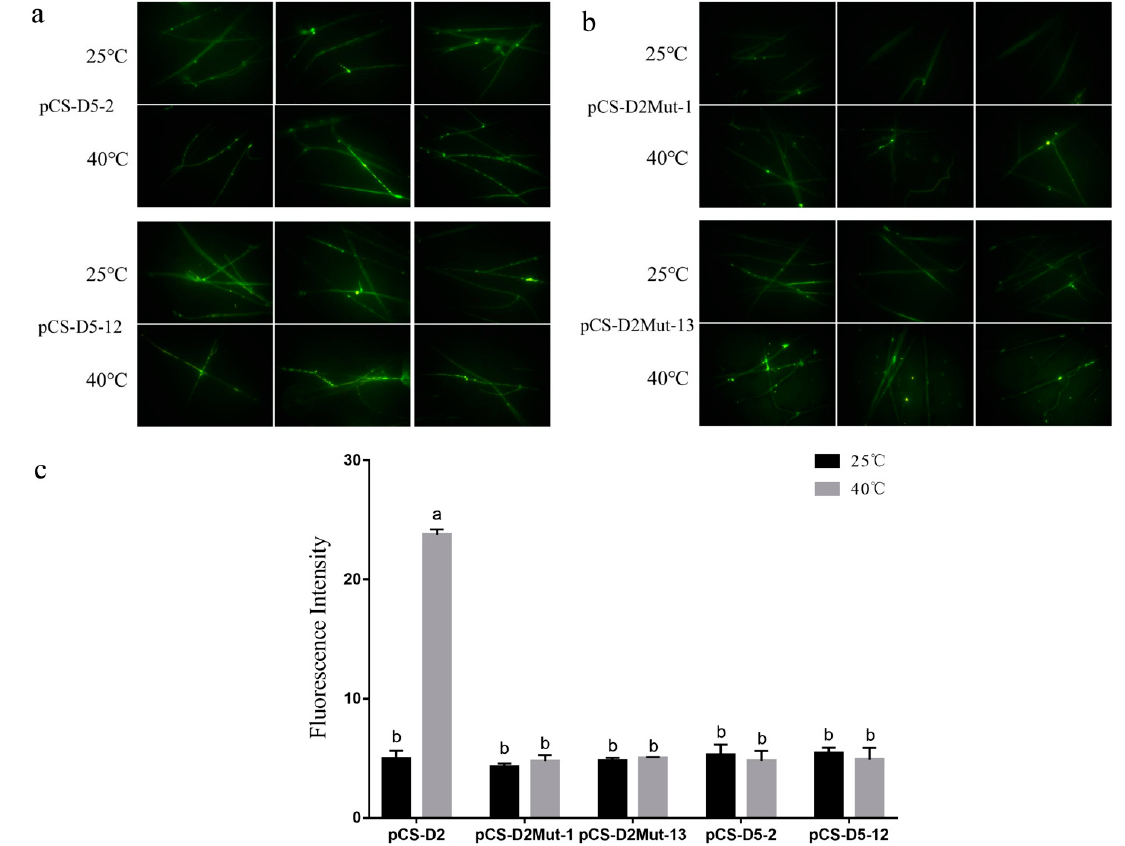
Figure 3. ( a ) Mycelia of pCS-D5 transformants before and after heat stress observed with an OLYMPUS BX51 fluorescence microscope; images were taken with a 40 × field of view. ( b ) Mycelia of pCS-D2Mut transformants before and after heat stress observed with an OLYMPUS BX51 fluorescence microscope; images were taken with a 40 × field of view. ( c ) The fluorescence intensity of pCS-D5 and pCS-D2Mut transformants before and after heat stress; n = 3, p <